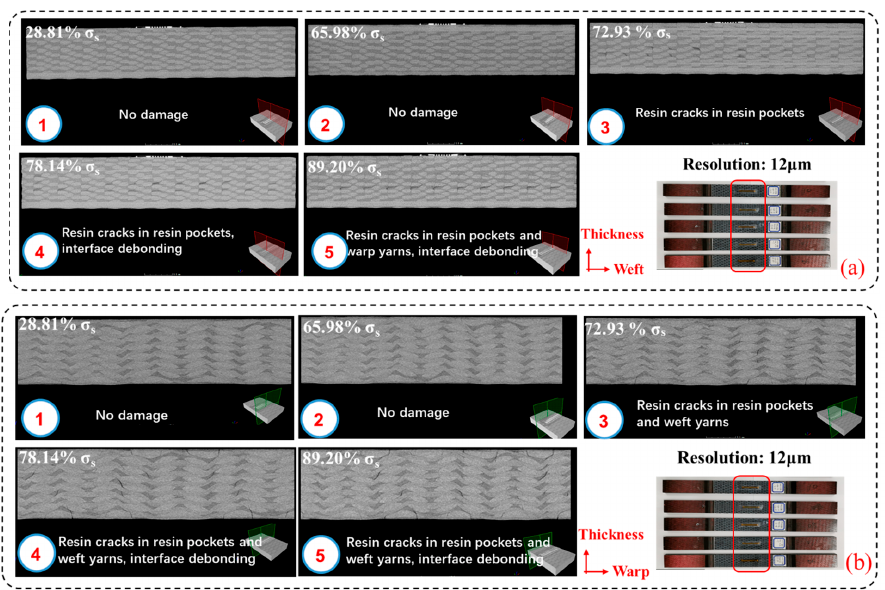
Figure 9. Micro-CT cross-sectional view of the phased specimens along the warp ( a ) and weft ( b ) directions, respectively.